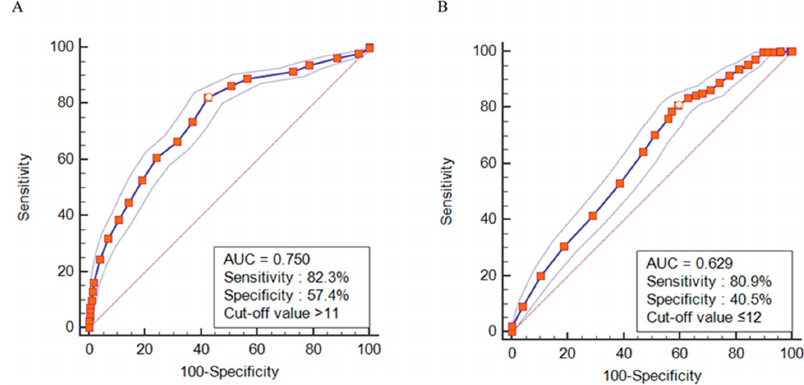
Figure 1. Receiver operating characteristic curve of TUG interval and OLS duration for predicting cognitive disorders. ( A ) Timed Up-to-Go test interval. ( B ) One-leg stand test duration. TUG, Timed Up-and-Go test; OLS, one-leg standing test; AUC, area under the curve.